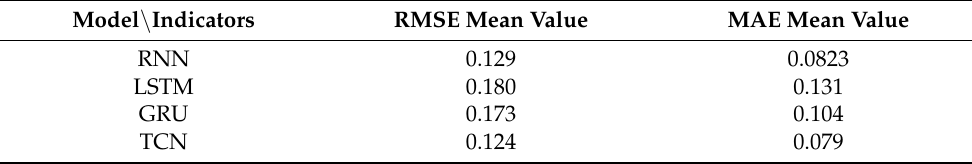
Table 3. Comparison of four models’ indicators.